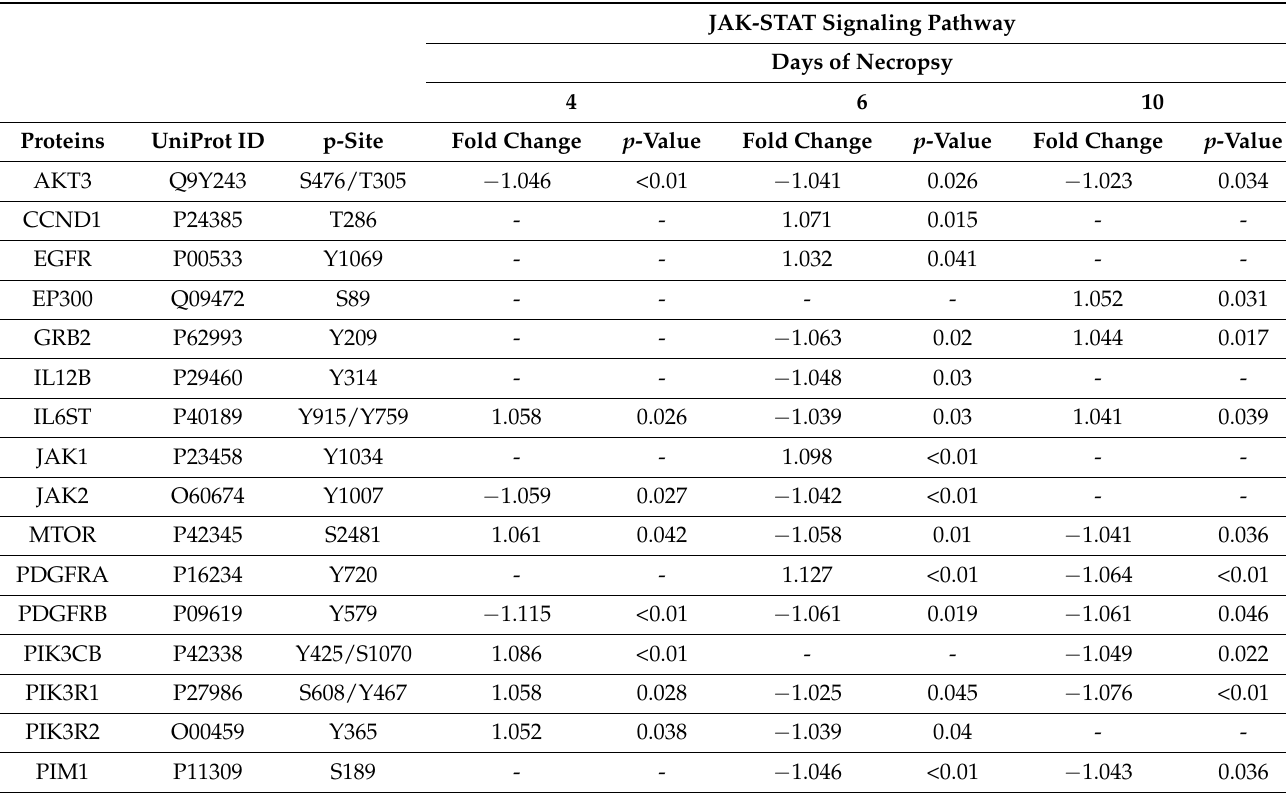
Table 2. Proteins from the JAK-STAT signaling pathway that displayed a statistically significant change in phosphorylation. The UniProt ID helps identify the protein. Positive fold change values indicate phosphorylation events; negative values indicate dephosphorylation events. Only proteins that displayed a p -value of less than 0.05 are